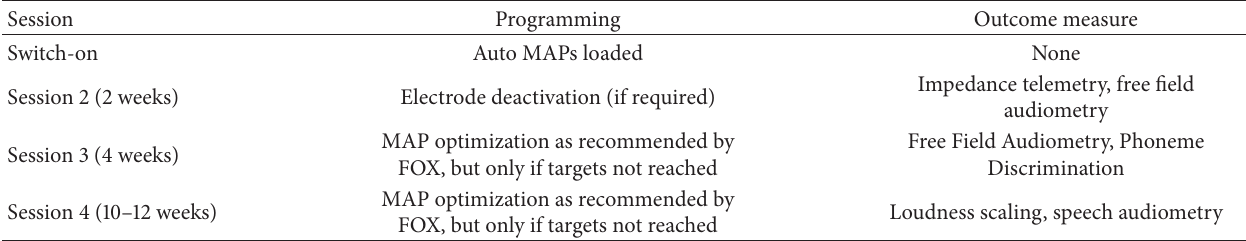
Table 1: Overview of the fitting procedure.